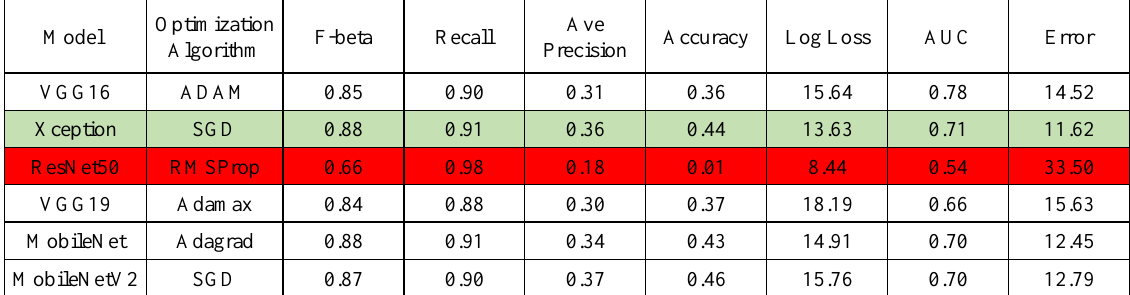
Table 2 . Operation correctness of the best classifiers after the first part of the research.